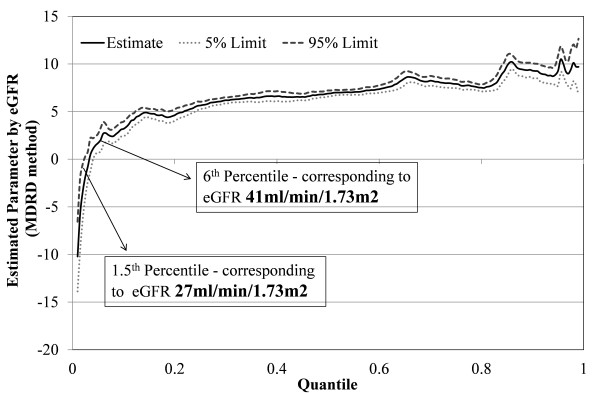
Quantile regression adjusted for comorbidities and age (fourth order polynomial) for MDRD equation. The X axis displays eGFRs by quantiles (0-0.2 being the lowest 20% and 0.8- 1.0 being the highest 20%). The Y axis shows the difference in eGFR in ml/min in blacks compared to whites. For example, a black individual with an eGFR at the 40th percentile would have an eGFR approximately 3 ml/min higher than a white individual by CKD-EPI method. Using the MDRD equation, a black at the 40th percentile, would have an eGFR approximately 6 ml/min higher than a white individual.